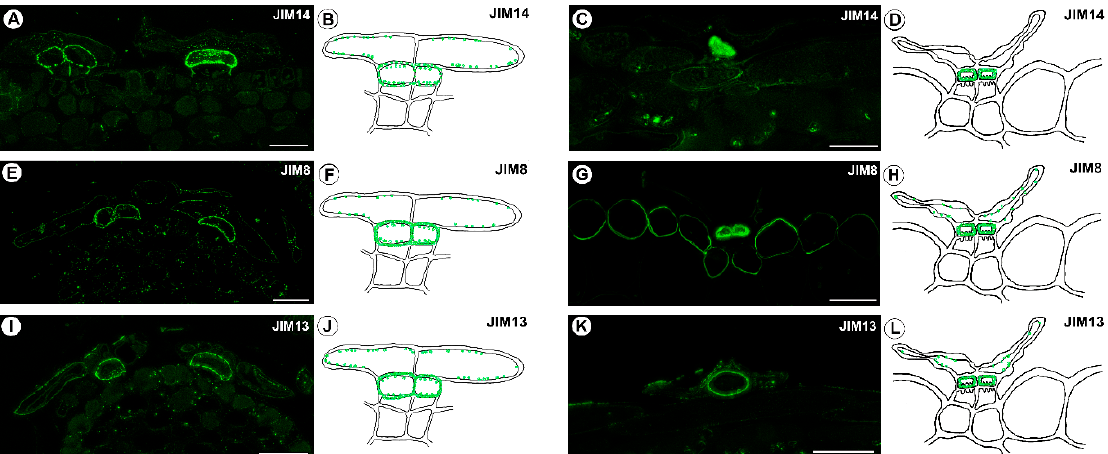
Figure 4. AGPs detected in the stellate trichomes of the Dionaea muscipula traps. ( A ) AGPs (labeled with JIM14) that were detected in the young trichomes, bar 20 µm. ( B ) Schematic occurrence (green) of the AGPs (labeled with JIM14) that were detected in a young trichome. ( C ) AGPs (labeled with JIM14) that were detected in a mature trichome, bar 20 µm. ( D ) Schematic occurrence (green) of the AGPs (labeled with JIM14) that were detected in a mature trichome. ( E ) AGPs (labeled with JIM8) that were detected in a young trichomes, bar 20 µm. ( F ) Schematic occurrence (green) of the AGPs (labeled with JIM18) that were detected in a young trichome. ( G ) AGPs (labeled with JIM8) that were detected in a mature trichome, bar 20 µm. ( H ) Schematic occurrence (green) of the AGPs (labeled with JIM8) that were detected in a mature trichome. ( I ) AGPs (labeled with JIM13) that were detected in a young trichomes, bar 20 µm. ( J ) Schematic occurrence (green color) of the AGPs (labeled with JIM13) that were detected in a young trichome. ( K ) AGPs (labeled with JIM13) that were detected in a mature trichome, bar 20 µm. ( L ) Schematic occurrence (green) of the AGPs (labeled with JIM13) that were detected in a mature trichome.